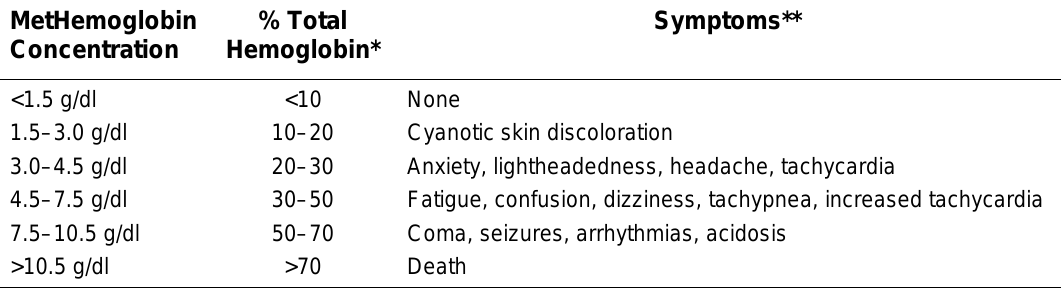
Clinical Manifestation of MetHb by MetHemoglobin